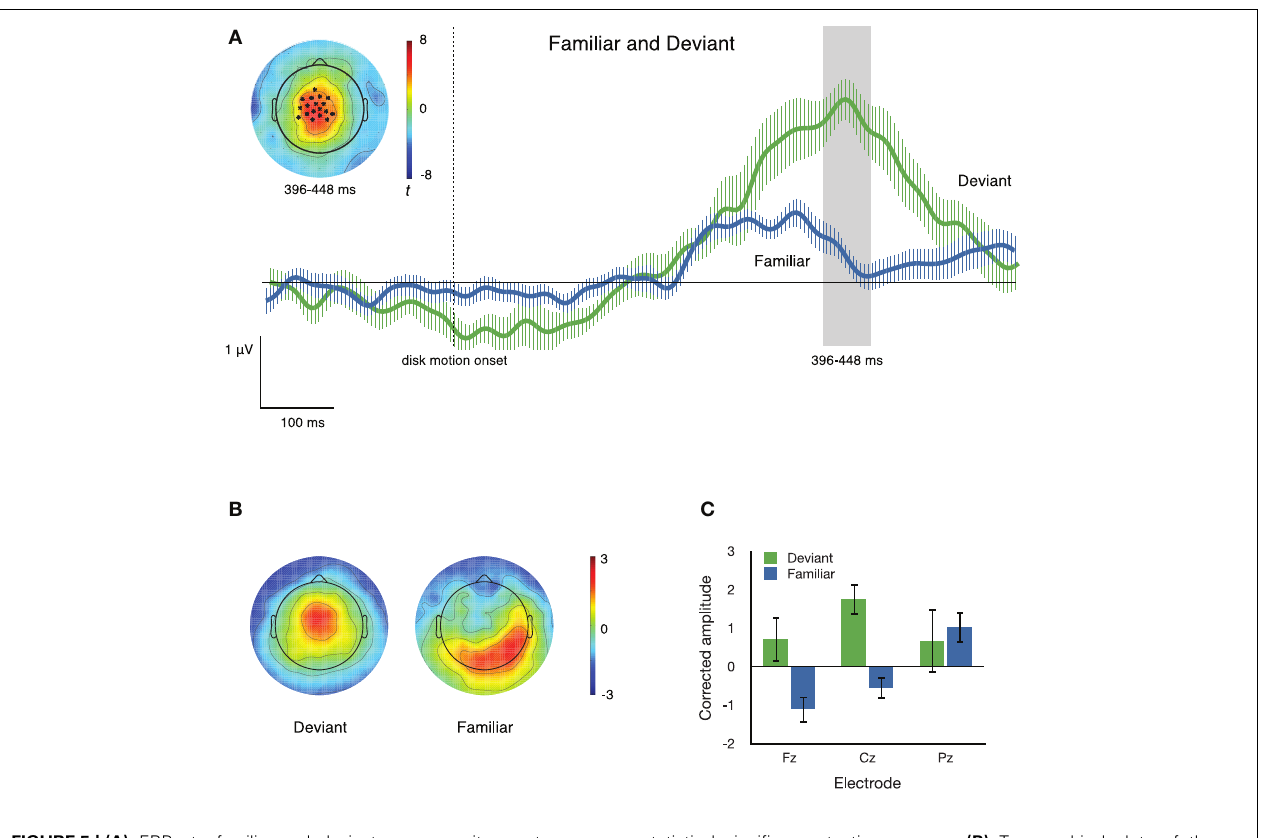
statistical significance testing process. (B) Topographical plots of the spatial distribution of voltage from 396 to 448ms after disk motion onset, after correcting for overall amplitude differences between conditions. Topographies appear to differ substantially. (C) Mean corrected amplitude from 396 to 448ms after disk motion onset, at three midline electrodes. The response to deviant items is significantly more positive-going than the response to familiar